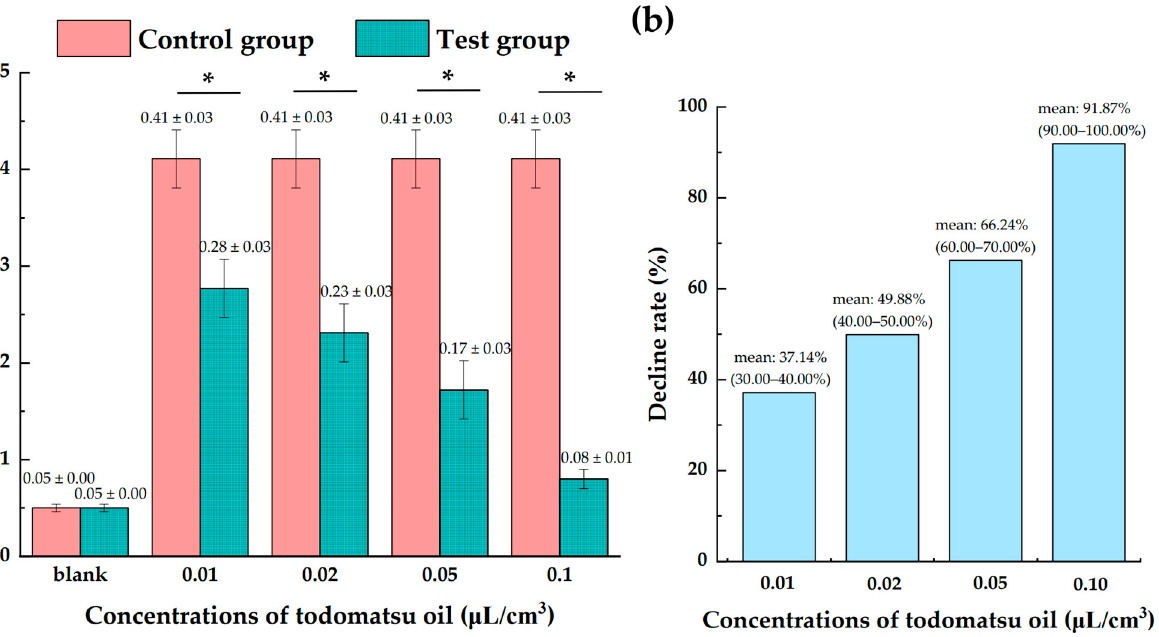
Figure 3. The decline rates of standard allergen Der f 1 in varied concentrations of todomatsu oil atmosphere were analyzed with ELISA. ( a ) OD 450nm values received from ELISA assay; ( b ) Decline rates. 250 ng/mL of standard allergen Der f 1 in the test group was exposed to 0.01, 0.02, 0.05, or 0.10 μ L/cm 3 of todomatsu oil atmosphere for 2 h at 25 °C. The oil-free equivalent of the test group was assigned as the control group. The value is the mean ± SD from three independent replicates of each sample. * signifies a significant difference ( p < 0.05).